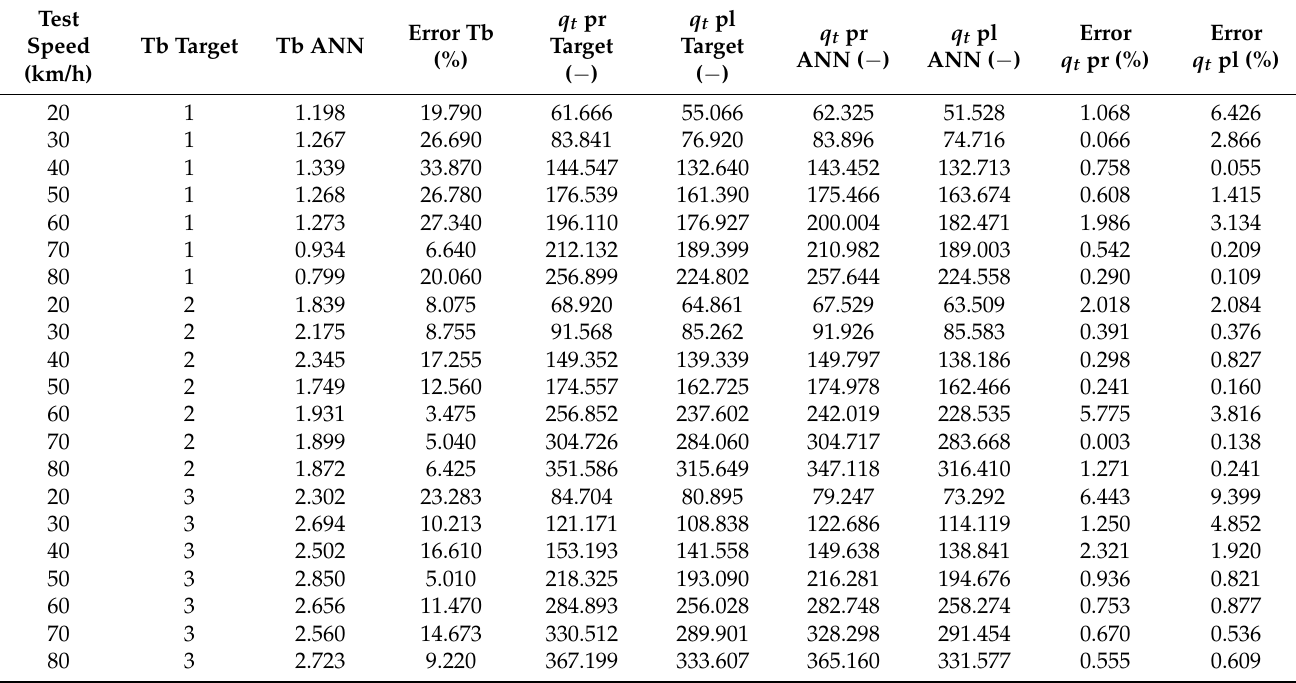
Table 5. Target and simulated values of braking type (Tb), right pressure sensor q t (pr), left pressure sensor q t (pl) and error.